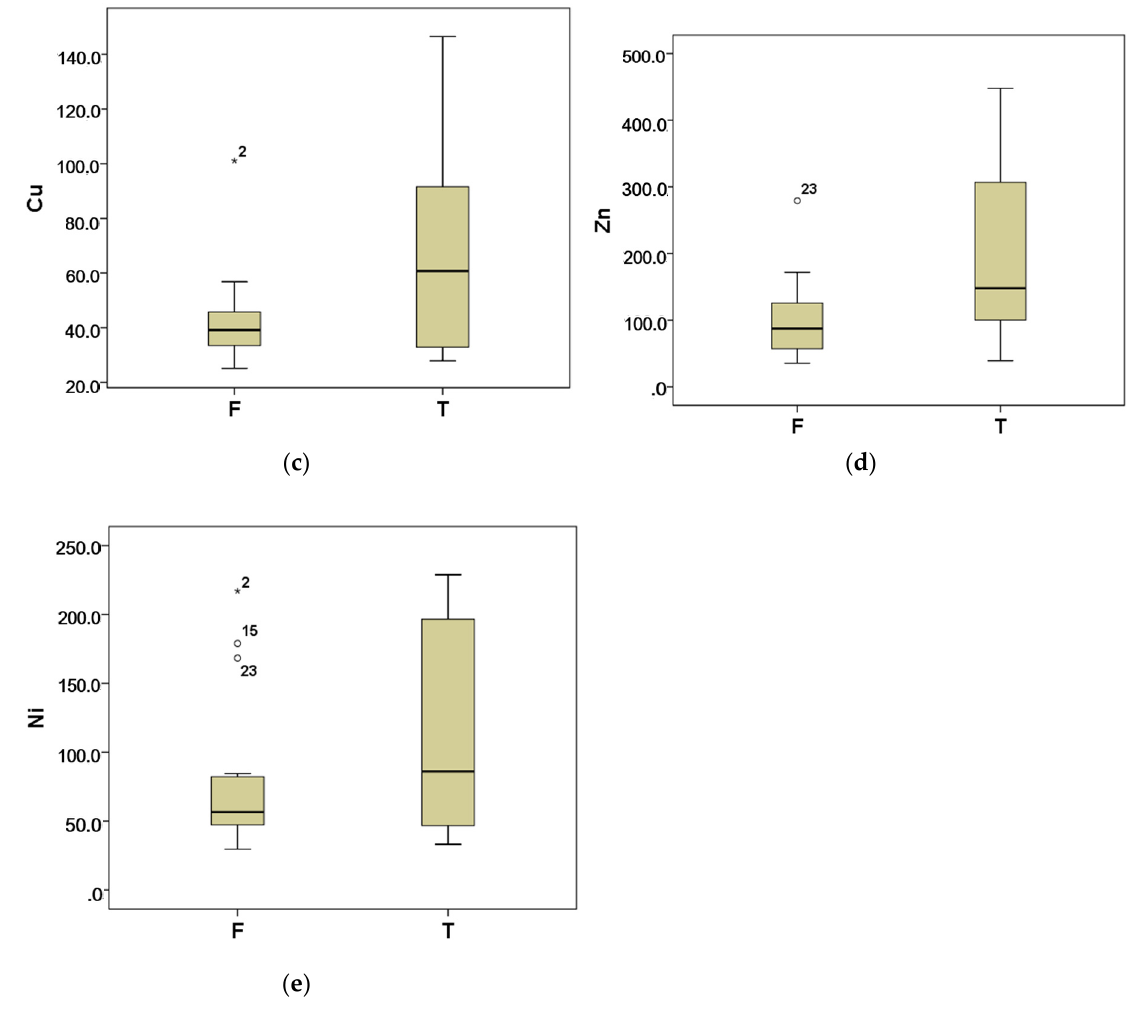
Figure 4. Box plots of data obtained for ( a ) Al, ( b ) Cd, ( c ) Cu, ( d ) Zn, and ( e ) Ni. The bottom and top of the box are the 25th and 75th percentiles; the line inside the box is the median (50th percentile), and the whiskers indicate the lowest and highest data within the 1.5 interquartile range. Concentration given in µ g L − 1